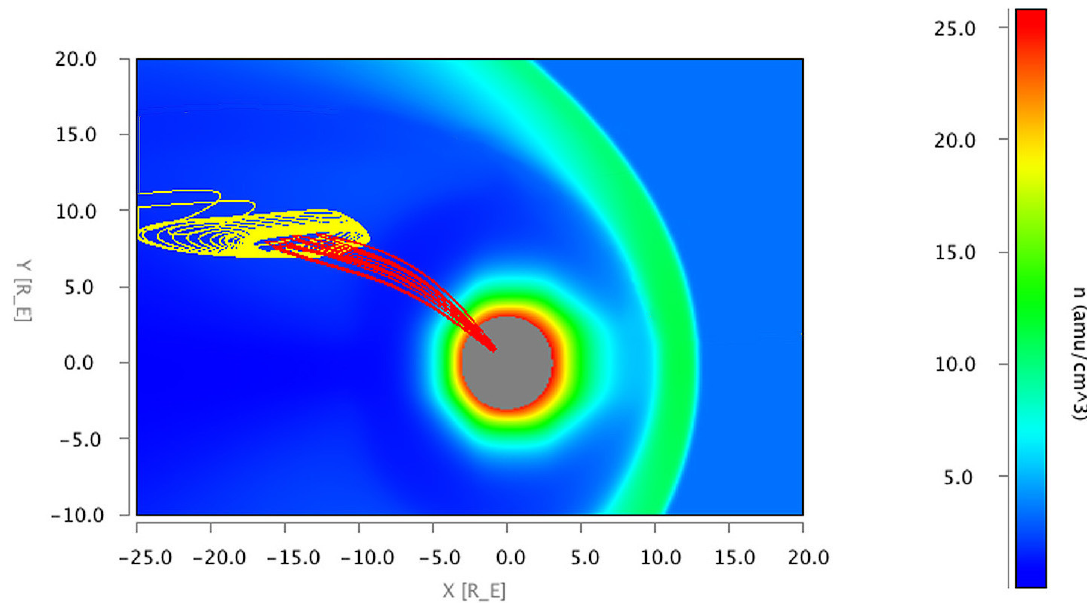
Fig. 17. A 3-D overview of the vortex in Fig. 5 using the Space Weather Explorer tool. The vortex rotation axis is parallel to the magnetic field lines. The background color represents the density, the yellow lines represent the flow and the red lines are the magnetospheric field